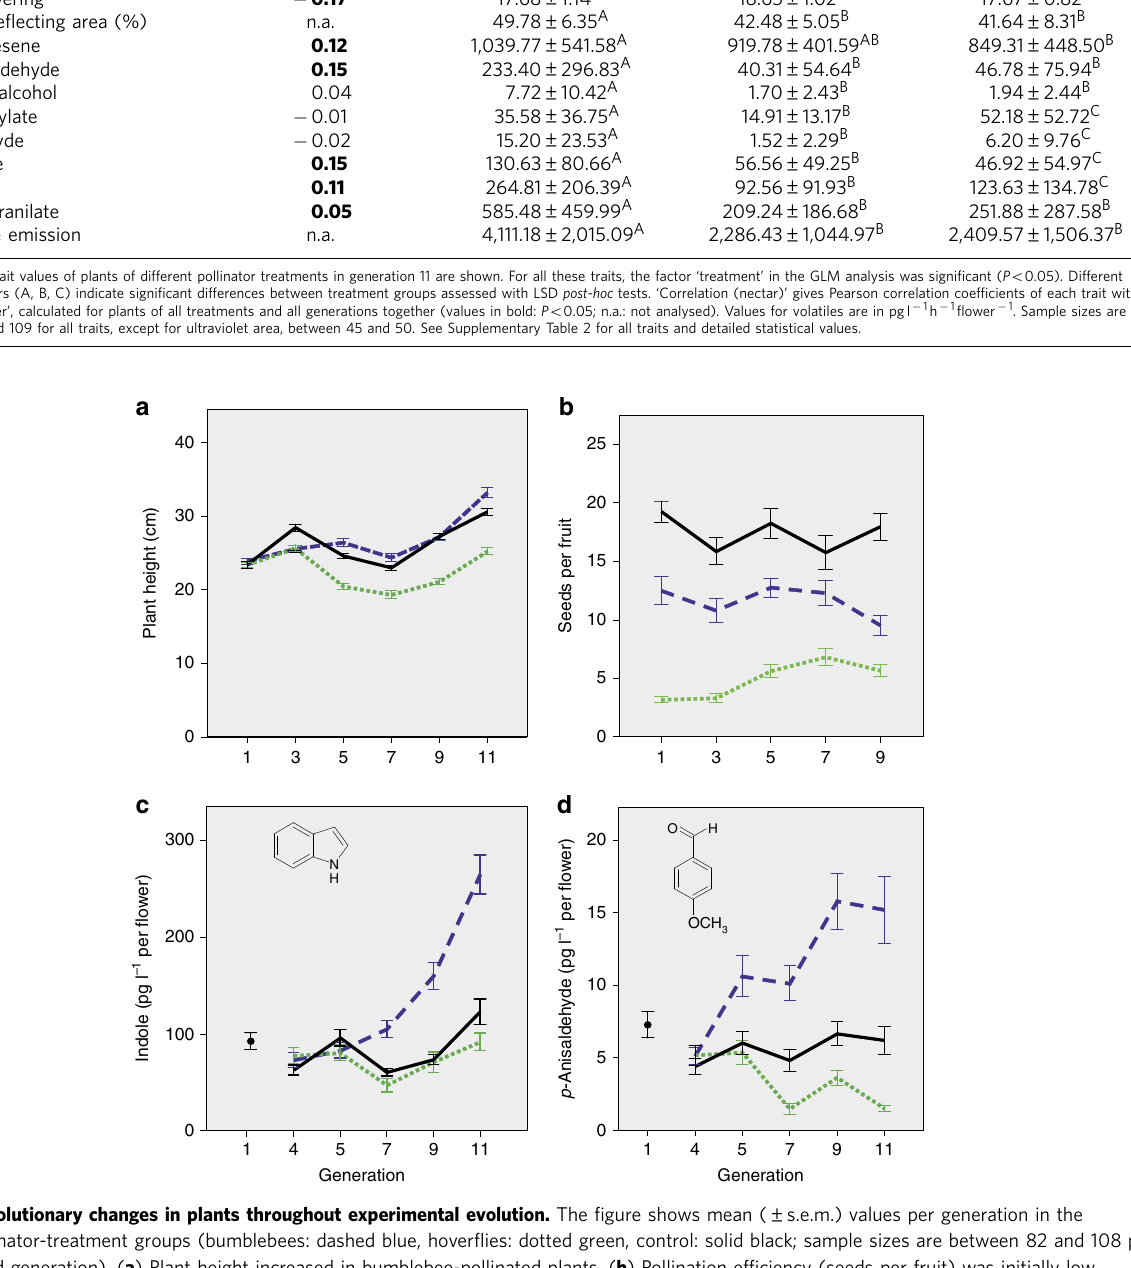
NATURE COMMUNICATIONS|8:14691|DOI: